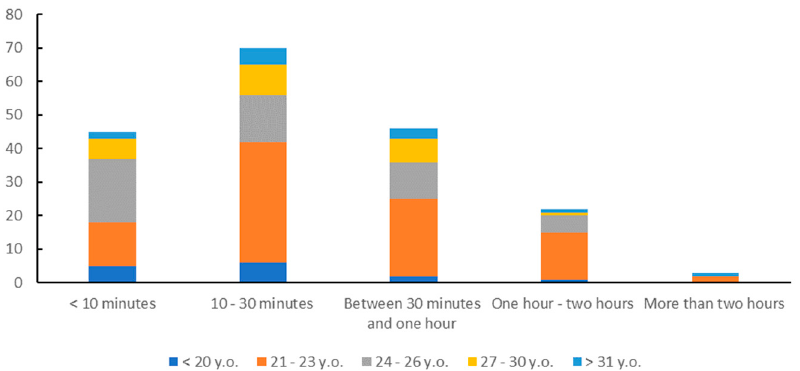
Figure 4. Time for reaching the university from the actual residence place, per each class of age.